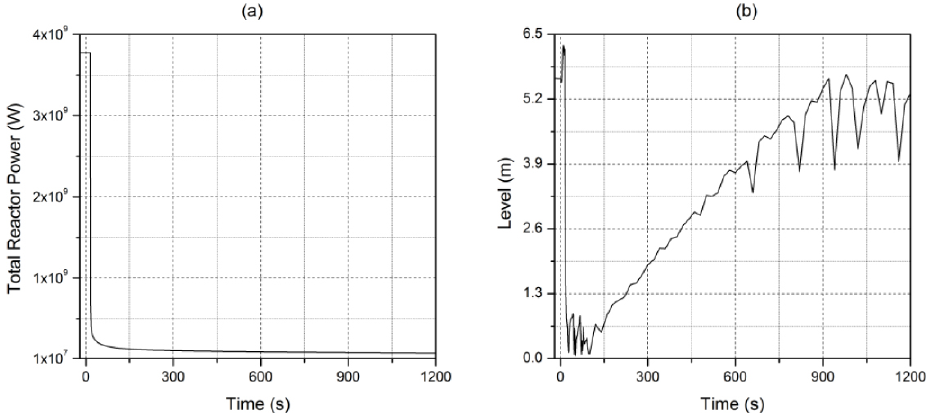
Fig. 7. Total reactor power (a). Steam generator 2 secondary side water level